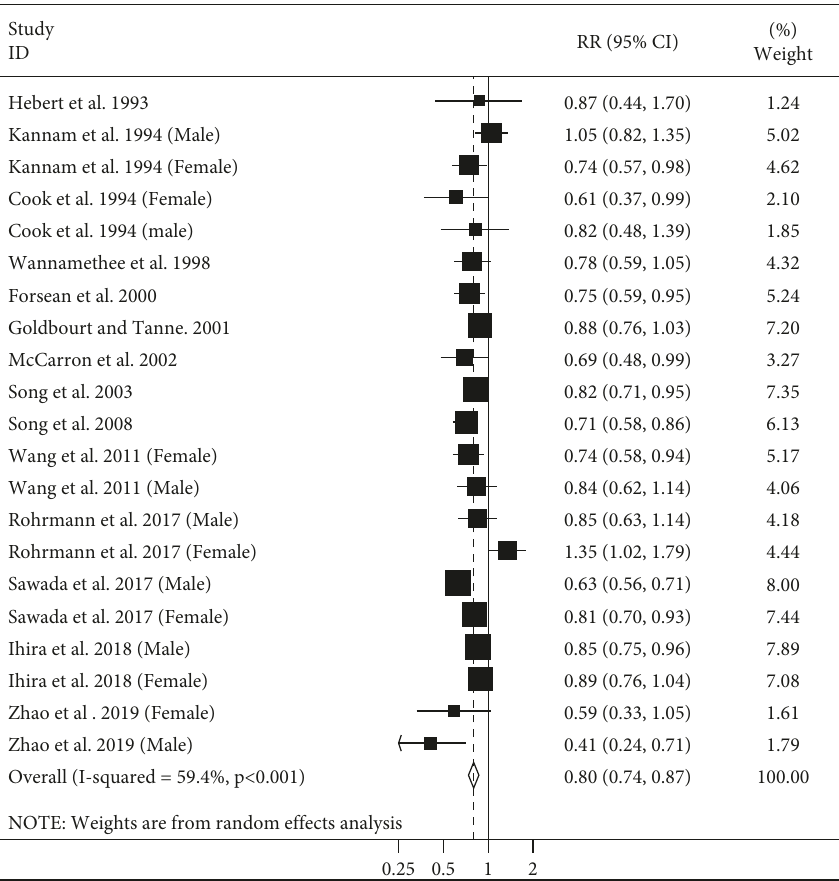
Figure 2: Forest plot for the association between adult height and CVD mortality by considering the highest and lowest height. Horizontal lines represent 95% CIs. Diamonds represent the pooled estimates from the random-effects analysis. RR: relative risk; CI: confidence interval.